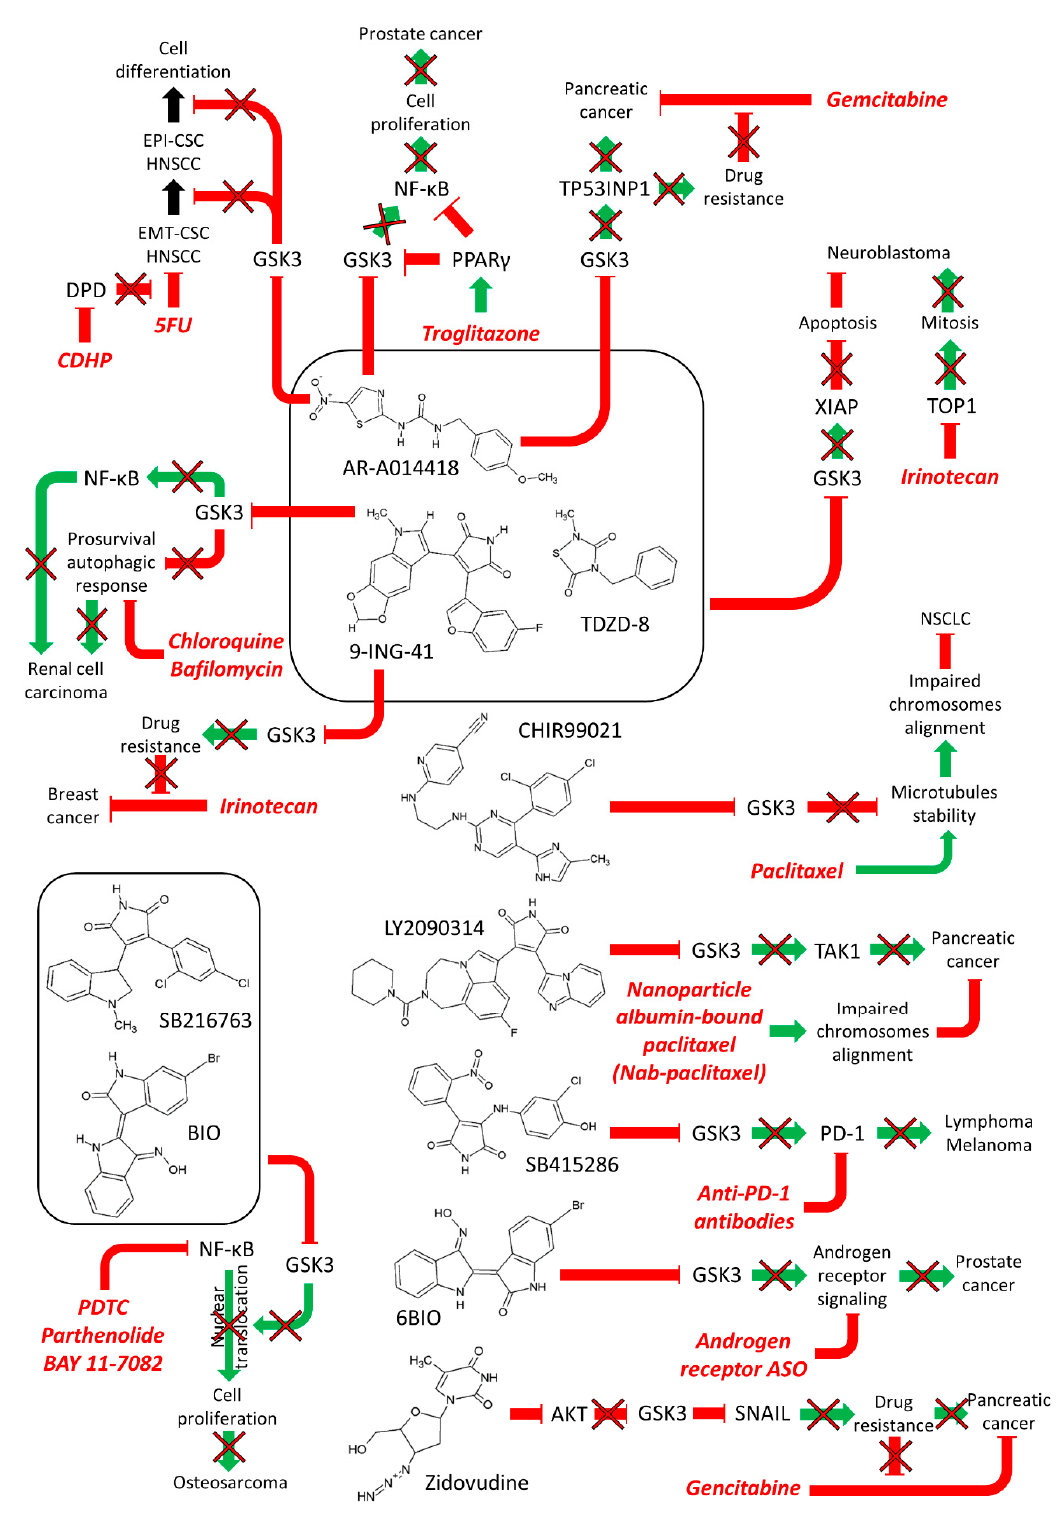
Figure 4. E ff ects of Combining GSK-3 Inhibitors with Chemotherapy or Immunotherapy. Green arrows Figure 4. Effects of Combining GSK-3 Inhibitors with Chemotherapy or Immunotherapy. Green indicate stimulation, blocked red arrows indicate arrows indicate stimulation, blocked red arrows indicate inhibition.